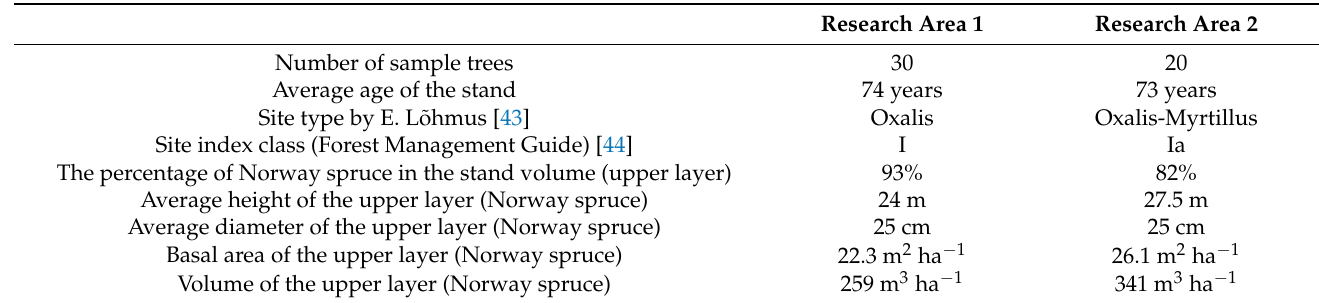
Table 1. Research area characteristics and dendrometric parameters (stand inventory data from the Estonian forest registry) [42].